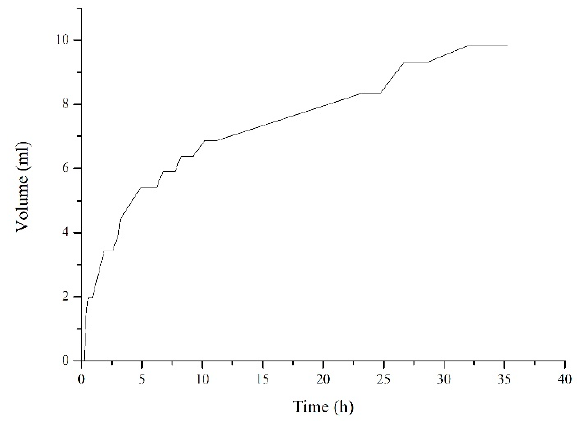
Figure 4. Volume process of injected water of stage two.